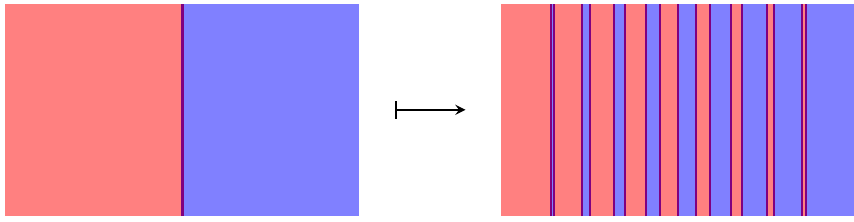
Figure 7 . The output of the composition f invertible defects between A and B g ! f paths from A to B g ! f invertible defects between A and B g